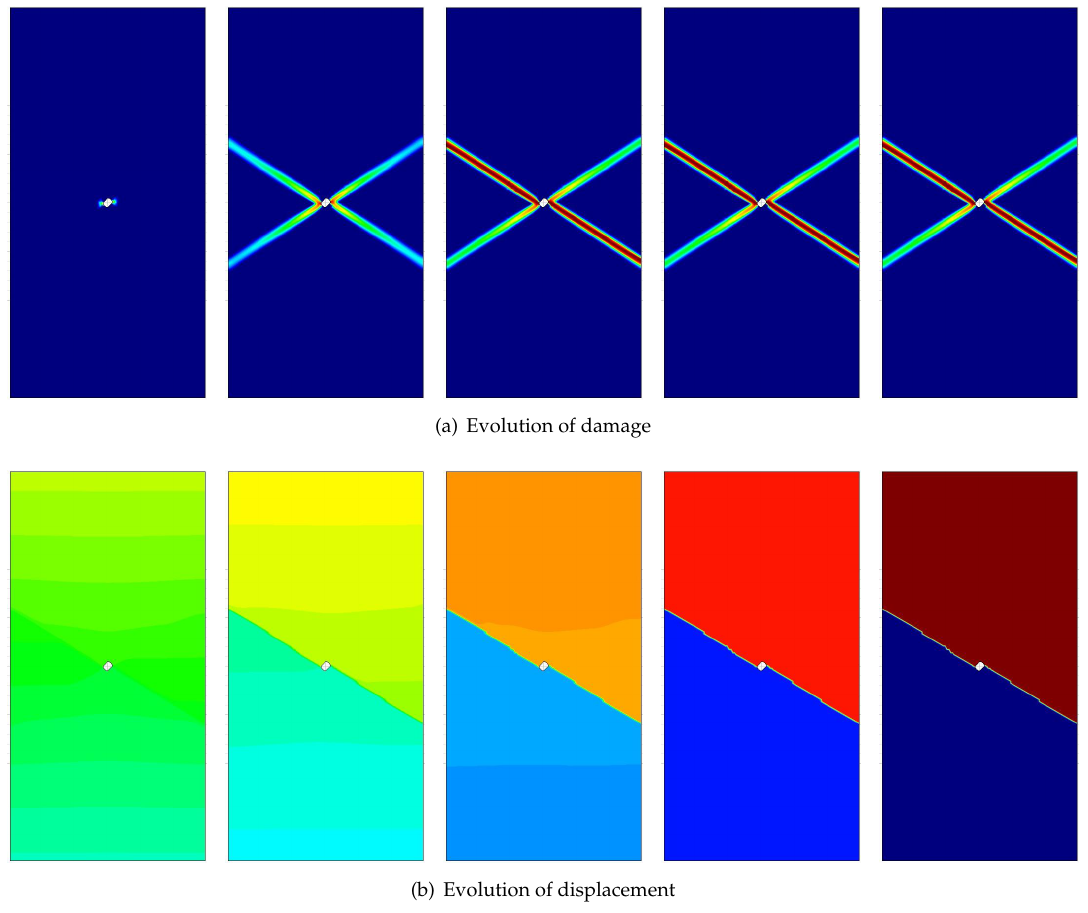
Figure 8. Uniaxial tension of a perforated strip: Load versus displacement curves for (cid:23) 0 D 0 . 3 .